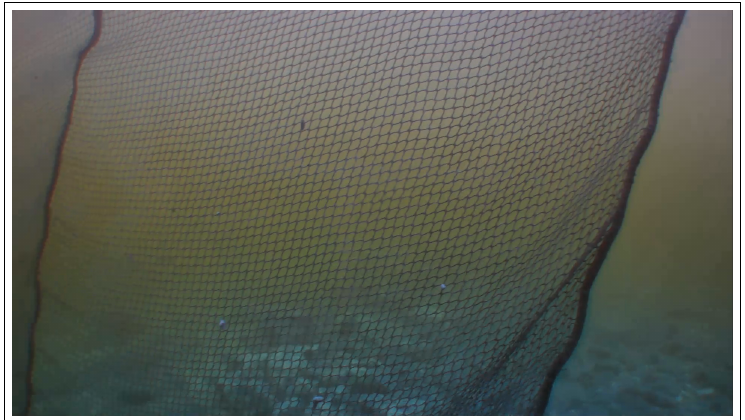
Figure 7. An example of the input image from the blueye vehicle camera obtained during the